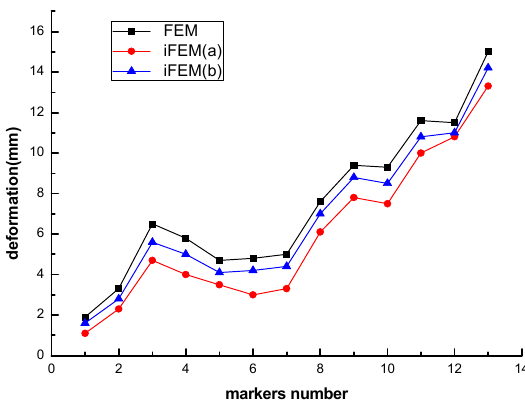
Figure 6. The deformation of the plate structure.